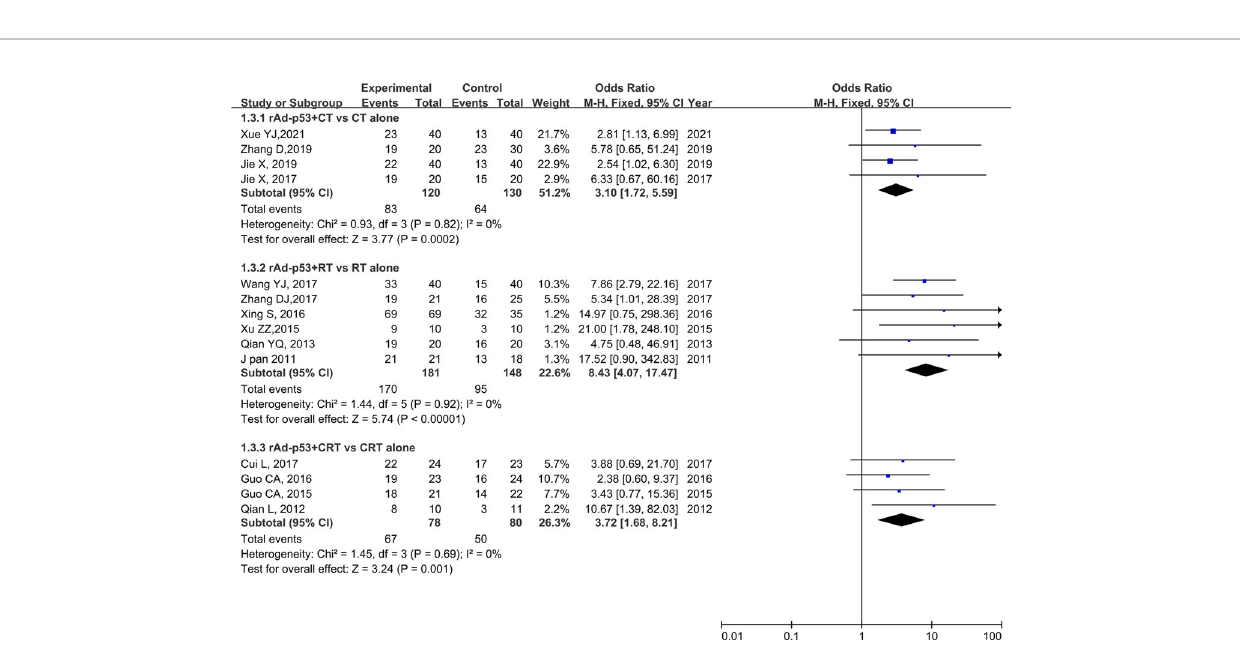
FIGURE 6 | Forest plot for subgroup analysis of PR based on CT/RT/CRT. PR, partial remission; CT, chemotherapy; RT, radiotherapy; CRT, chemoradiation therapy.